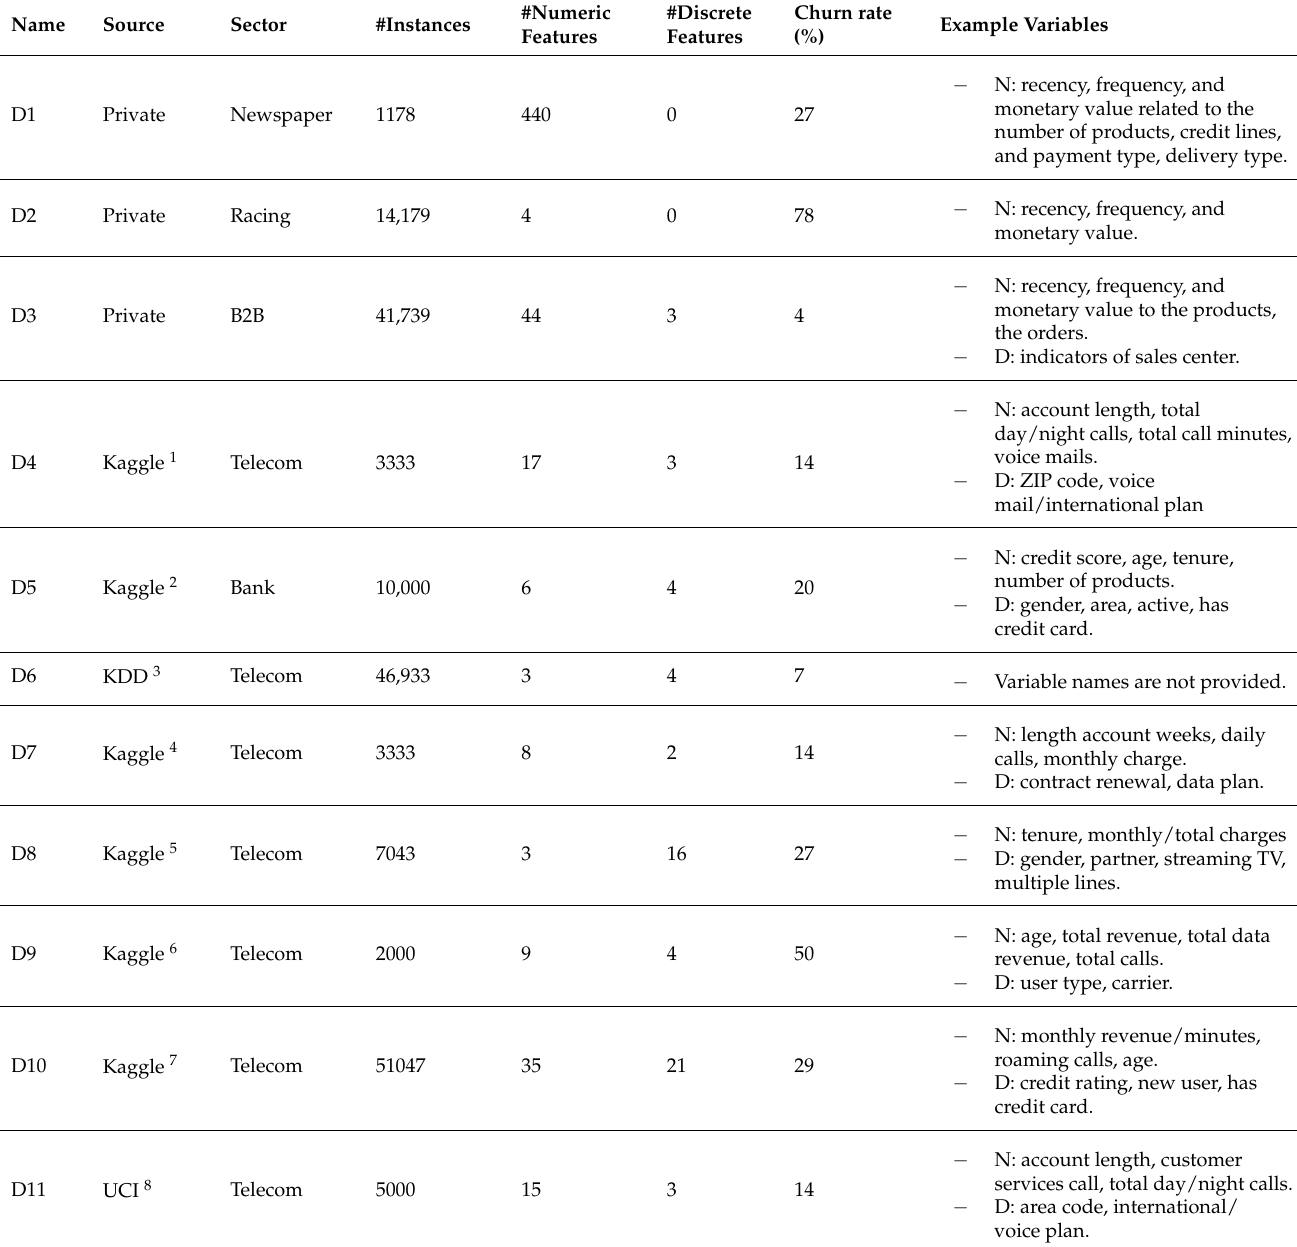
Table 5. Overview and characteristics of the data sets. For each data set some sample numeric (N) and discrete (D) are